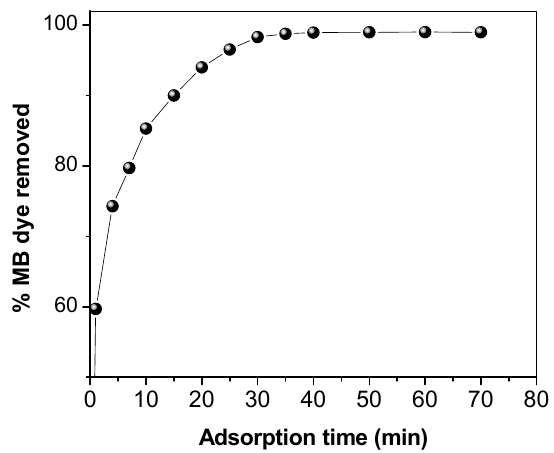
Figure 4. Effect of adsorption time on the percentage of methylene blue dye (MB) removed from an aqueous solution by synthetic nano-clay magadiite (SNCM).